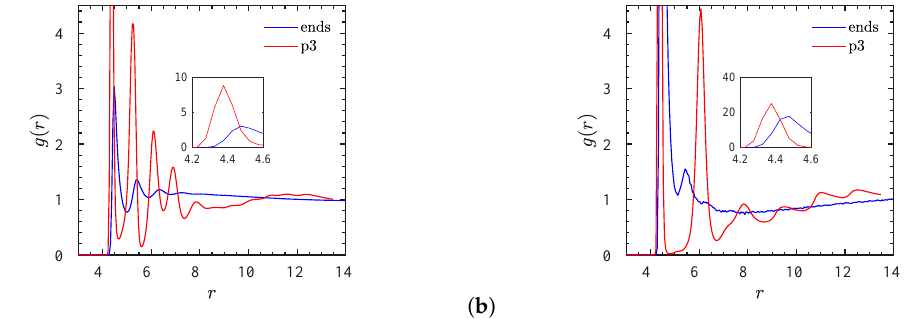
Figure 3. ( a ) NP center–monomer and ( b ) NP center–charged monomer radial distribution functions for dispersed systems with a degree of polymerization N = 200, and an NP volume fraction of φ = 11.6%. The insets show the corresponding values of the first peak in g ( r ) .